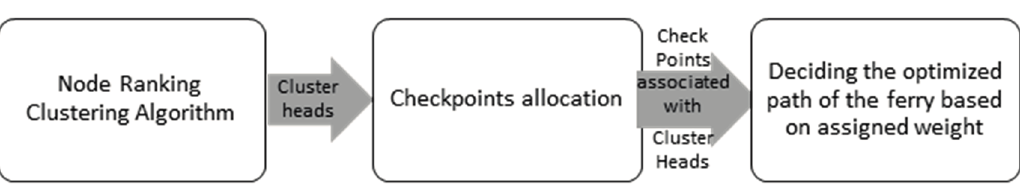
Figure 1. Illustration of phases used by